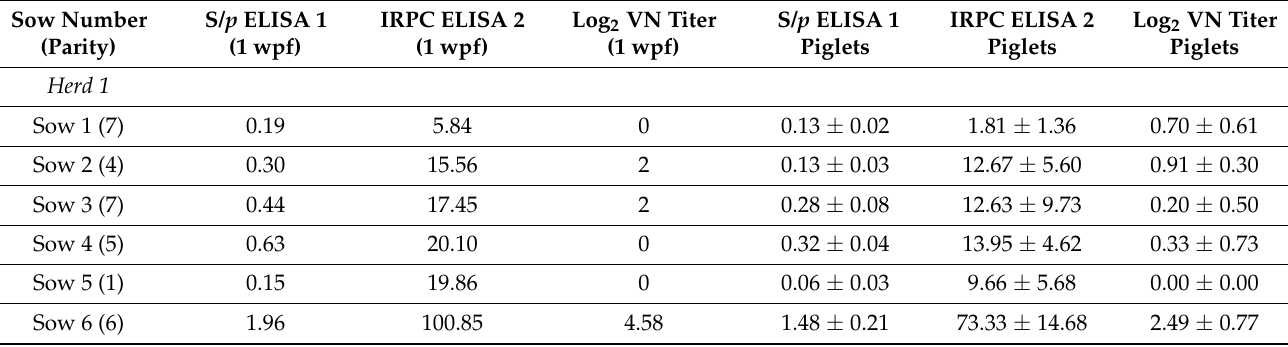
Figure 2. Presence of PRRSv-specific maternally-derived antibodies (MDAs) in piglets born from PRRSv-vaccinated seropositive sows (E+ piglets) and PRRSv-vaccinated seronegative sows (E − piglets) in two Belgian farrow-to-finish herds. PRRSv-specific MDAs were analyzed at 3 weeks of age (herd 1) or 4 weeks of age (herd 2). MDAs were analyzed using IDEXX ELISA (ELISA 1– left ), CIVTEST ELISA (ELISA 2– middle ) and virus neutralization assay (VN– right ). Individual ELISA 1 S/ p values, ELISA 2 IRPC values or VN titers (Log 2 ) are shown as dots on the graphs. Cut-off values for seropositivity are indicated with a dotted line. An unpaired t-test was used to compare the MDA ratios between E+ sows and E − sows. **** p -value < 0.0001; * p -value < 0.05; ns = not significant. Table 3. Presence of PRRSv-specific maternally-derived antibodies (MDAs) in piglets born from PRRSv-vaccinated seropositive sows and PRRSv-vaccinated seronegative sows in two Belgian farrow-to-finish herds. Sows were analyzed at 1 week post-farrowing (1 wpf) using IDEXX ELISA (ELISA 1), CIVTEST ELISA (ELISA 2) and virus neutralization assay (VN). Piglets were analyzed at 3 weeks of age (herd 1) or 4 weeks of age (herd 2) using ELISA 1, ELISA 2 and VN. Piglet values are shown as mean ± standard deviation.